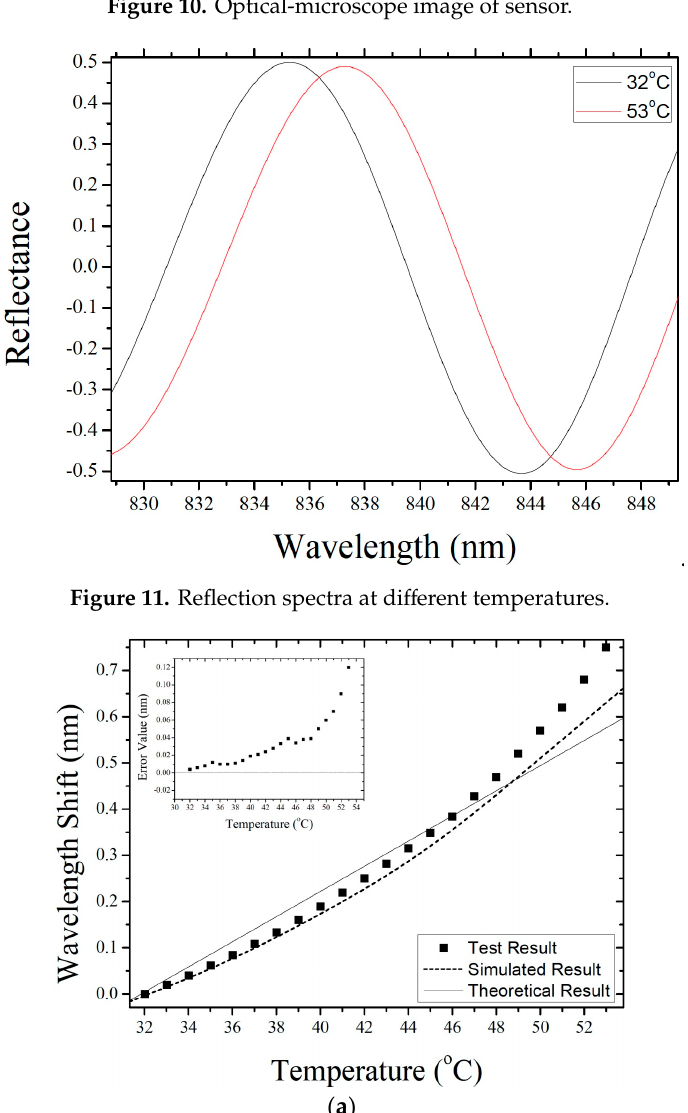
( a ) ( a ) ( a ) Figure 12. Cont